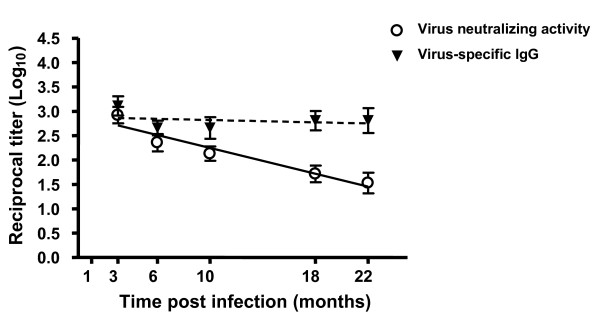
Neutralizing titers of γHV68 decline progressively with time after infection. Serum titers of γHV68-specific IgG (closed triangles) and neutralizing antibody (open circles) were measured in individual mice at the indicated months post infection. Symbols represent the mean reciprocal titers (log10), ± standard deviation, calculated at each timepoint (≥ 8 mice analyzed per timepoint). A linear regression was performed analyzing time versus reciprocal titer for virus-specific IgG or neutralizing antibody. The slope for virus specific IgG did not differ significantly from zero (p = 0.6780), however the slope for virus neutralizing antibody did (p = 0.0085).